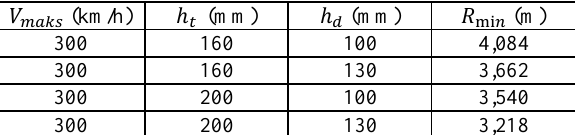
Table 2. Calculated curve